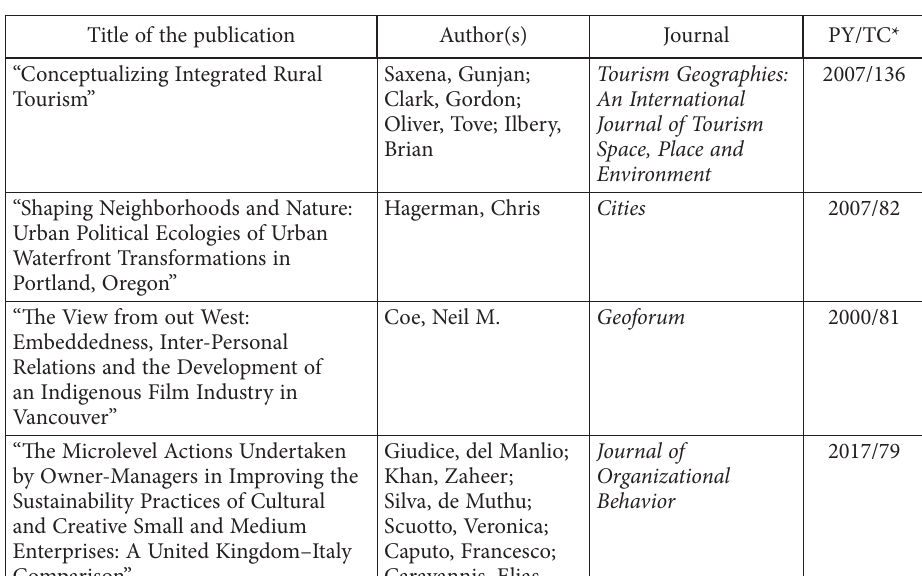
Table 3. Fifteen the most influential articles (source: created by the